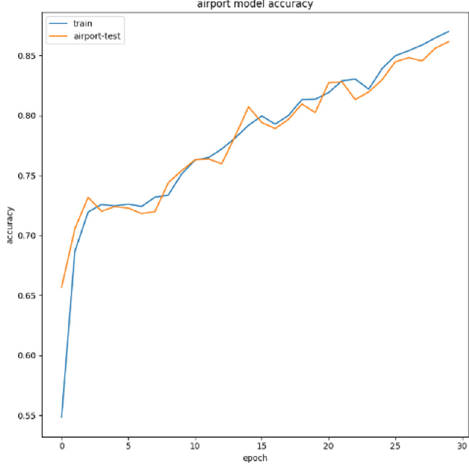
Figure 21. Airport target recognition accuracy.